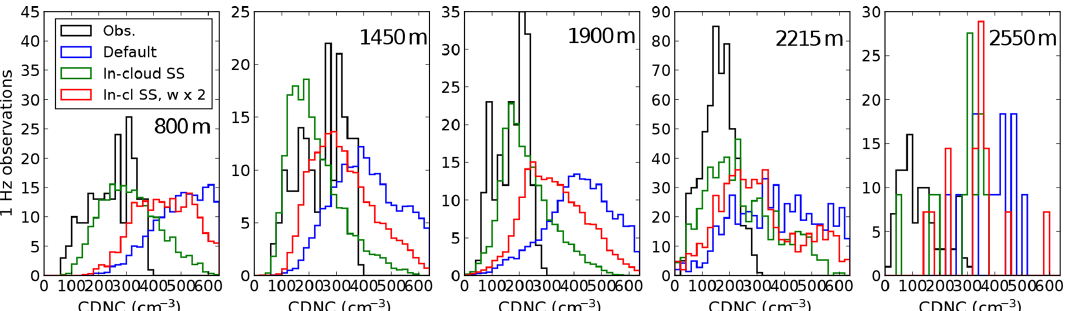
Figure 11. Comparison of in-cloud cloud droplet number distributions in the five straight-and-level runs at altitudes of 800, 1450, 1900, 2215 and 2550m from left to right. Each plot shows the old version of the model, labelled “Default”; the case where the reduction of supersaturation in clouds is accounted for, “in-cloud SS”; and the cases where this reduction is accounted for and the updraught speed in the activation scheme is increased by a factor 2, “in-cl SS, w × 2”. Only model grid boxes and CDP observations where the liquid water content exceeds 0 . 15gkg − 1 are